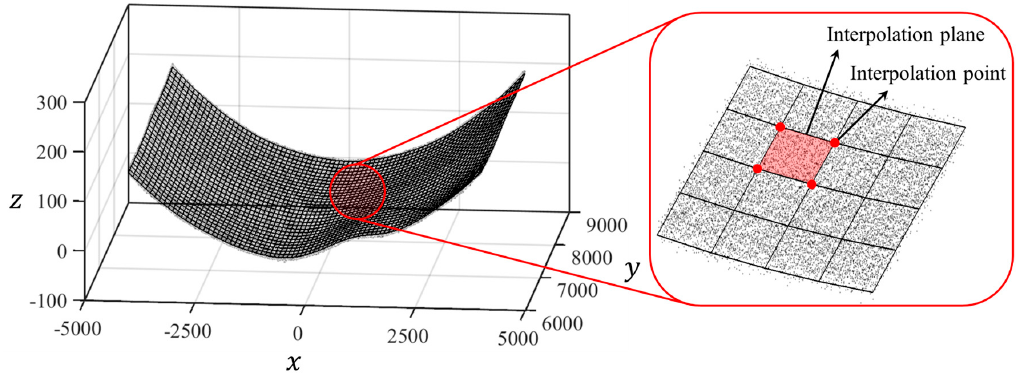
Figure 11. Transformed point cloud and mesh model [Unit: mm ].